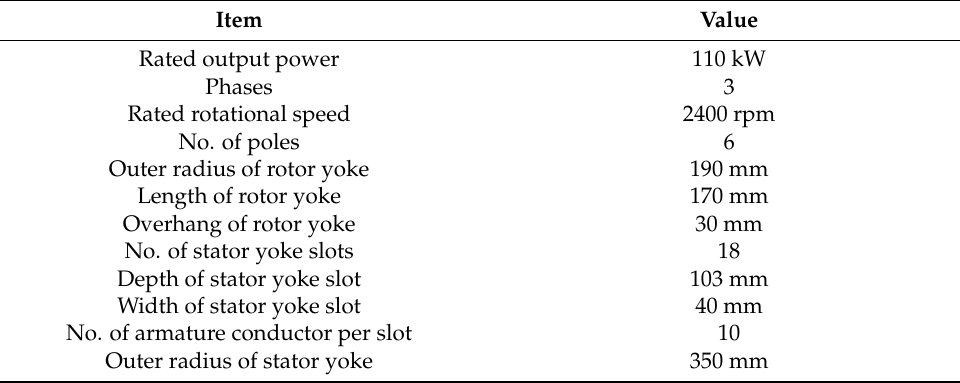
Figure 6. Fundamental design process of the HTS homopolar synchronous machine. Table 2. Design specifications of the HTS HSM.